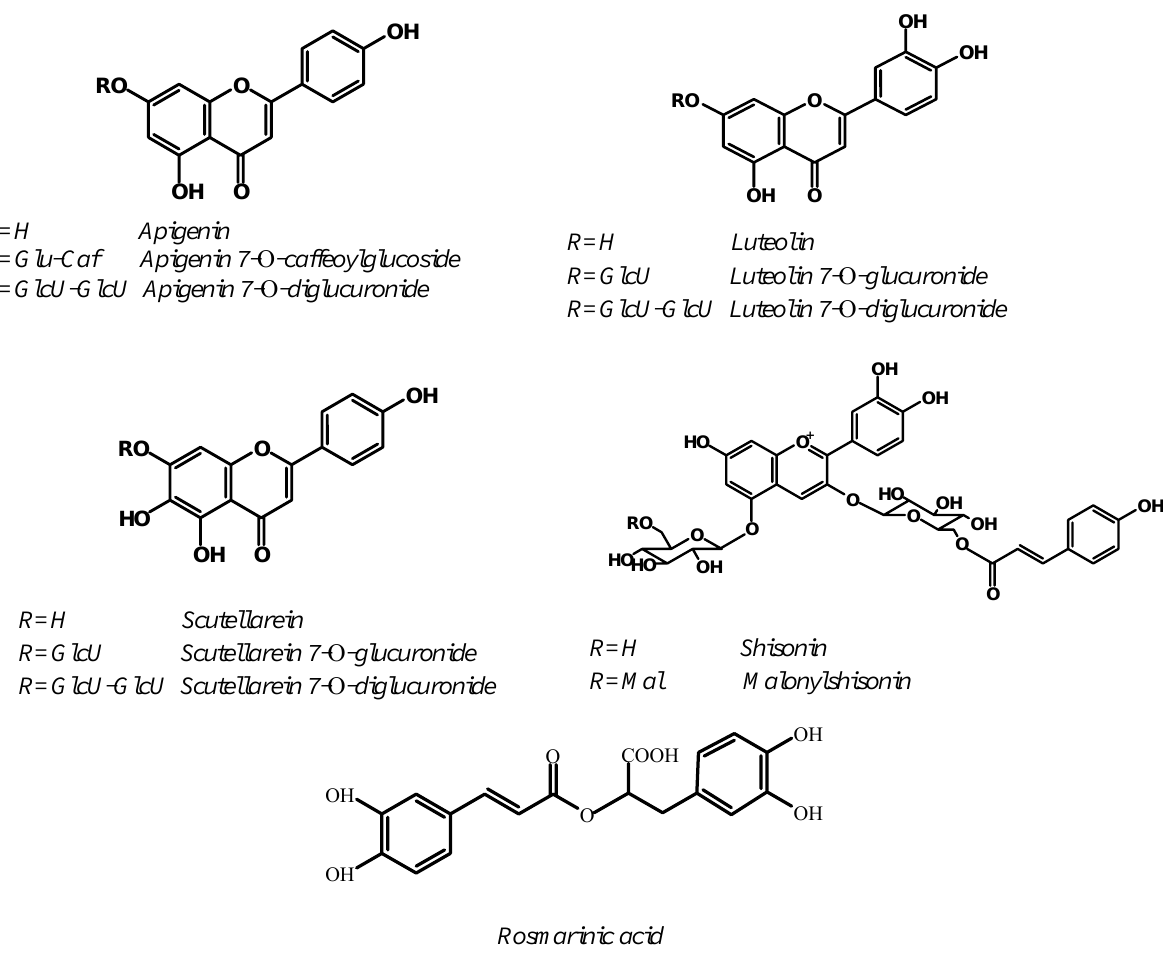
Figure 1 . Chemical Structures of major Polyphenolic Compounds in P. frutescens